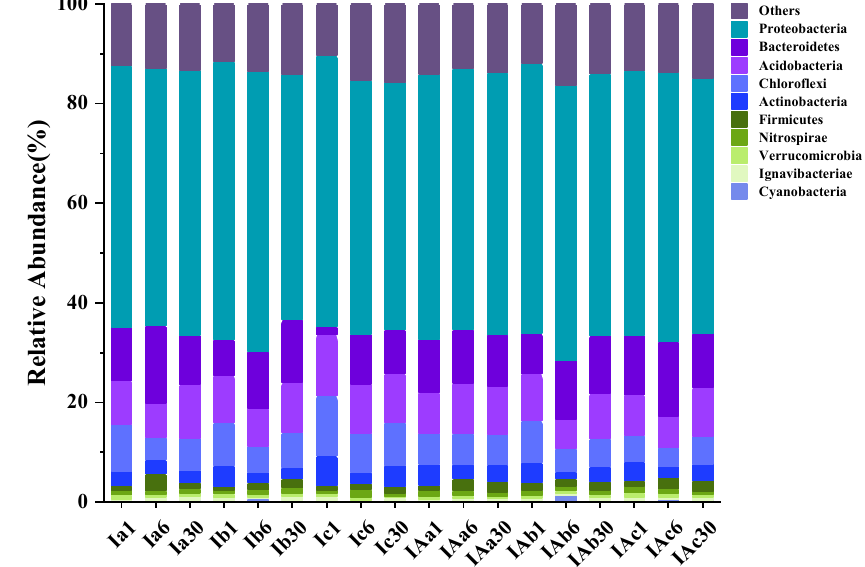
Figure 6. Relative abundances of bacterial compositions on the phylum level.